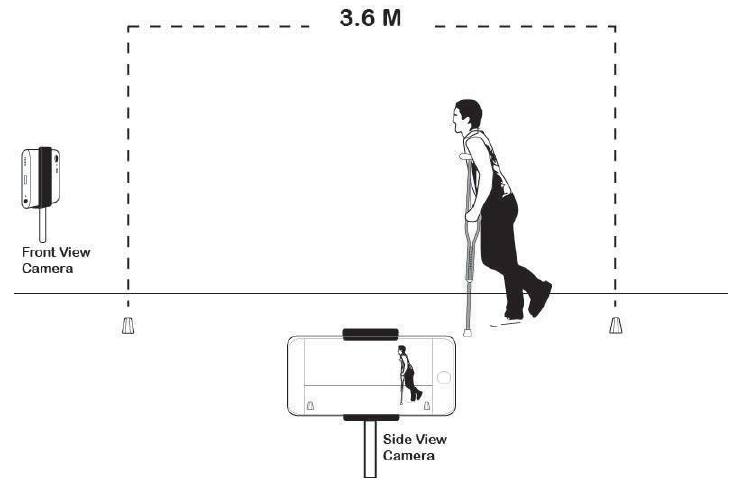
Figure 1. Walkway layout in the lab.